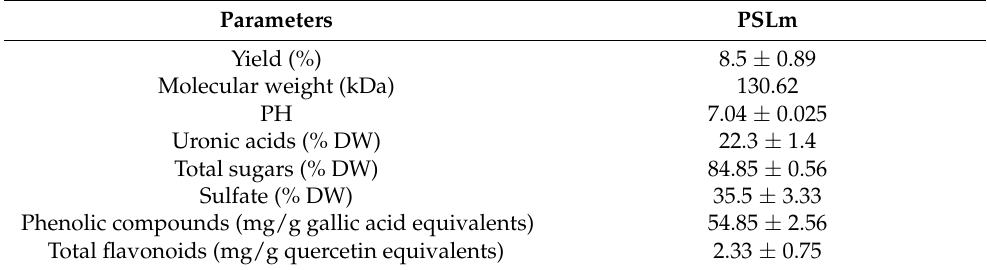
Table 1. Physicochemical characteristics of the crude polysaccharide extract of L. maritima . Parameters